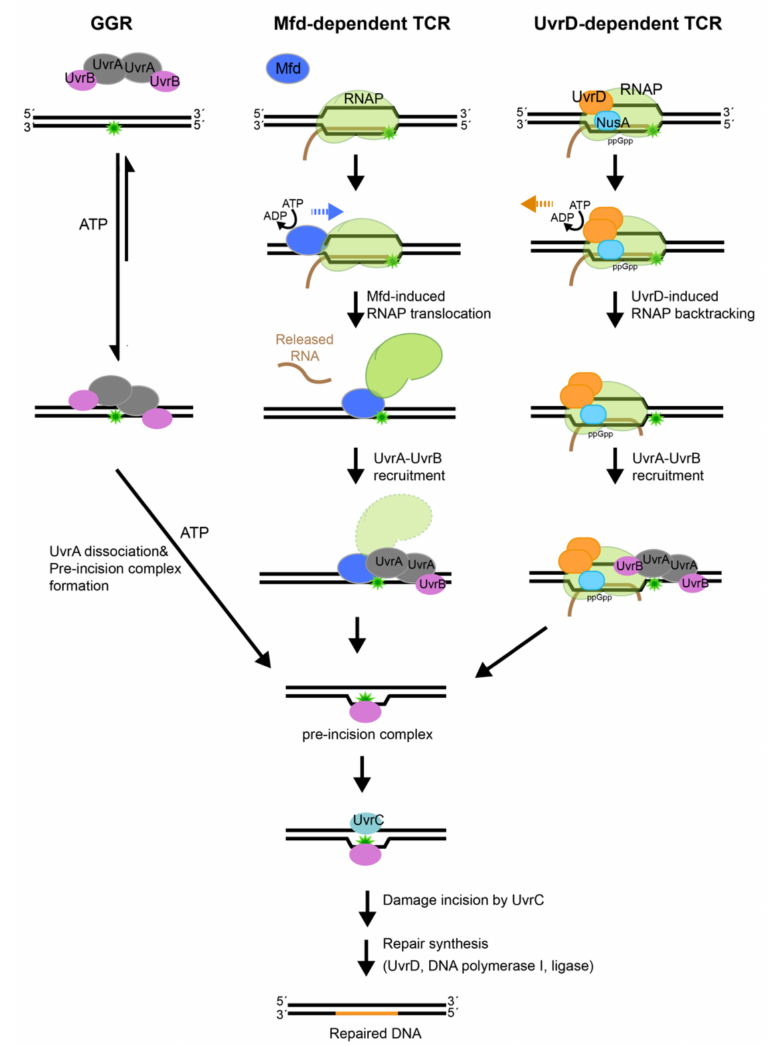
Figure 1. The nucleotide excision repair (NER) pathways. Nucleotide excision repair can occur via different sub-pathways. In global genome repair (GGR), the DNA damage is recognized by the UvrA 2 B 2 damage sensor. Transcription couple repair (TCR), which removes lesions form the DNA strand that is being transcribed, is mediated by the Mfd protein. Mfd binds to RNA polymerase (RNAP) that is stalled by the lesion, pushes it forward to expose the lesion and recruits the nucleotide excision repair (NER) machinery. Recently, an alternative pathway has been proposed for TCR that is dependent on UvrD. In this newly proposed sub-pathway, UvrD binds to the stalled RNAP in the presence of the transcription elongation factor NusA and ppGpp and induces backtracking to expose the lesion; this is followed by lesion recognition by NER proteins. All three sub-pathways culminate in the formation of UvrB • DNA pre-incision complex, which commits the bound DNA for incision and subsequent